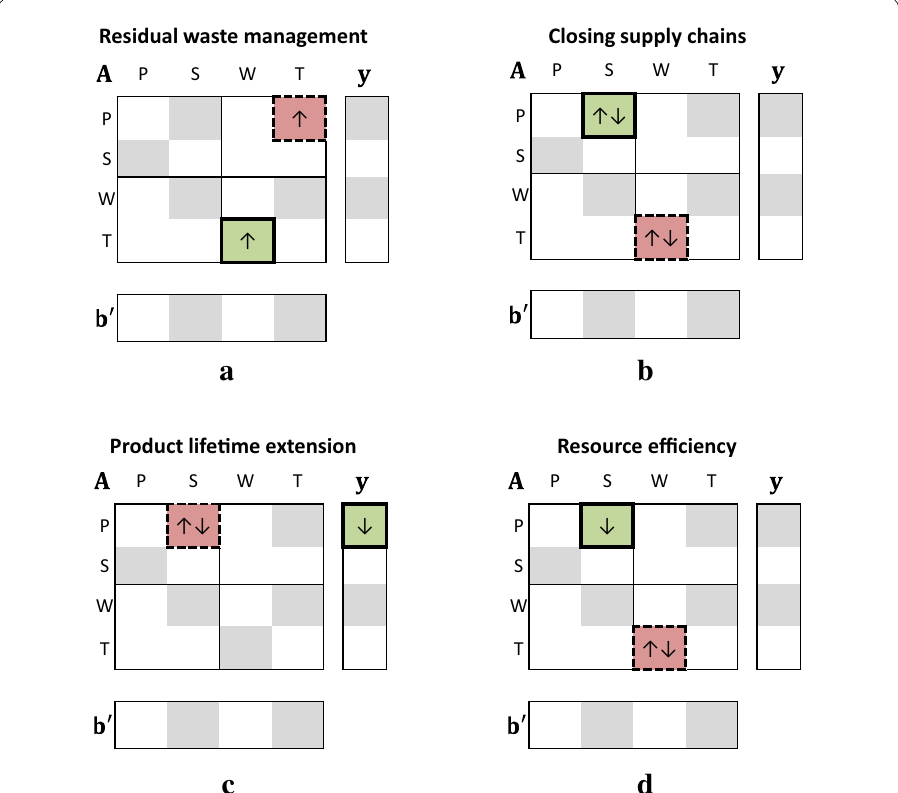
Fig. 4 Modelling causality sequence of a residual waste management, b closing supply chains, c product lifetime extension, and d resource efficiency. y final demand vector, A technology matrix, b ′ intensity = = = vector. P product or service, S sector or industry, W waste, T waste treatment or recycling activity. = = = = Green square with solid line border (‘ ― ’) indicates primary sequence, and red square with dash line border (‘ ‐‐‐ ’) represents secondary sequence. ‘ ’ indicates a relative increase in A‑matrix coefficients, ’ ’ indicates ↑ ↓ a relative decrease in A‑matrix coefficients, ‘ ’ indicates a simultaneous change in different sectors or ↑↓ industries caused by the same causal